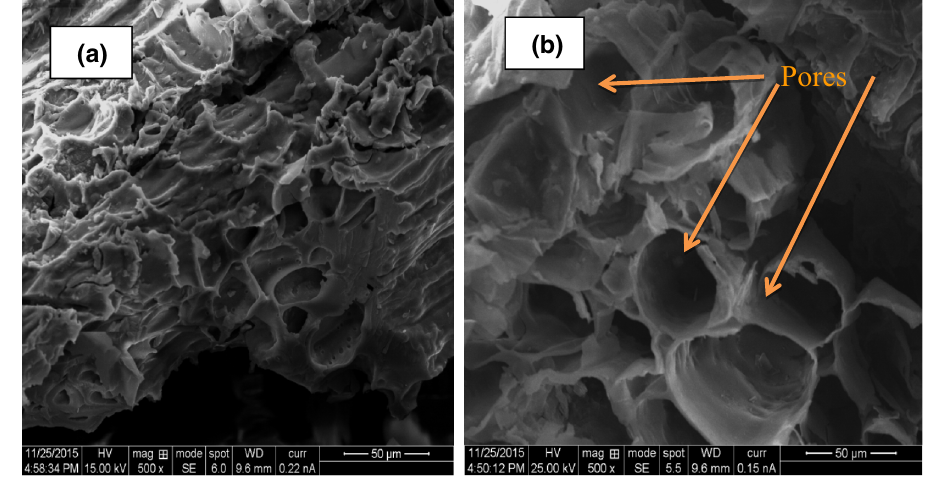
Fig. 2 SEM images of a CHR (Mag × 500) and b CHA (Mag × 500)